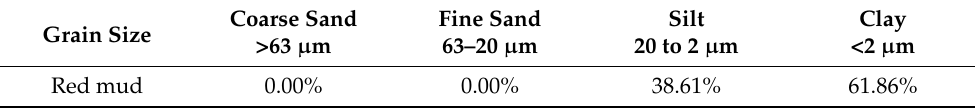
Table 13. Particle size distribution of bauxite residue (Red mud).